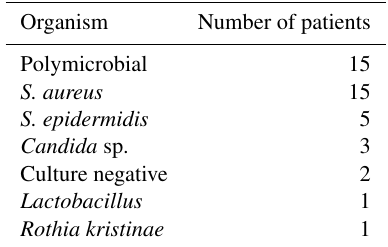
Table 3. Microbiological results (of 27 infected